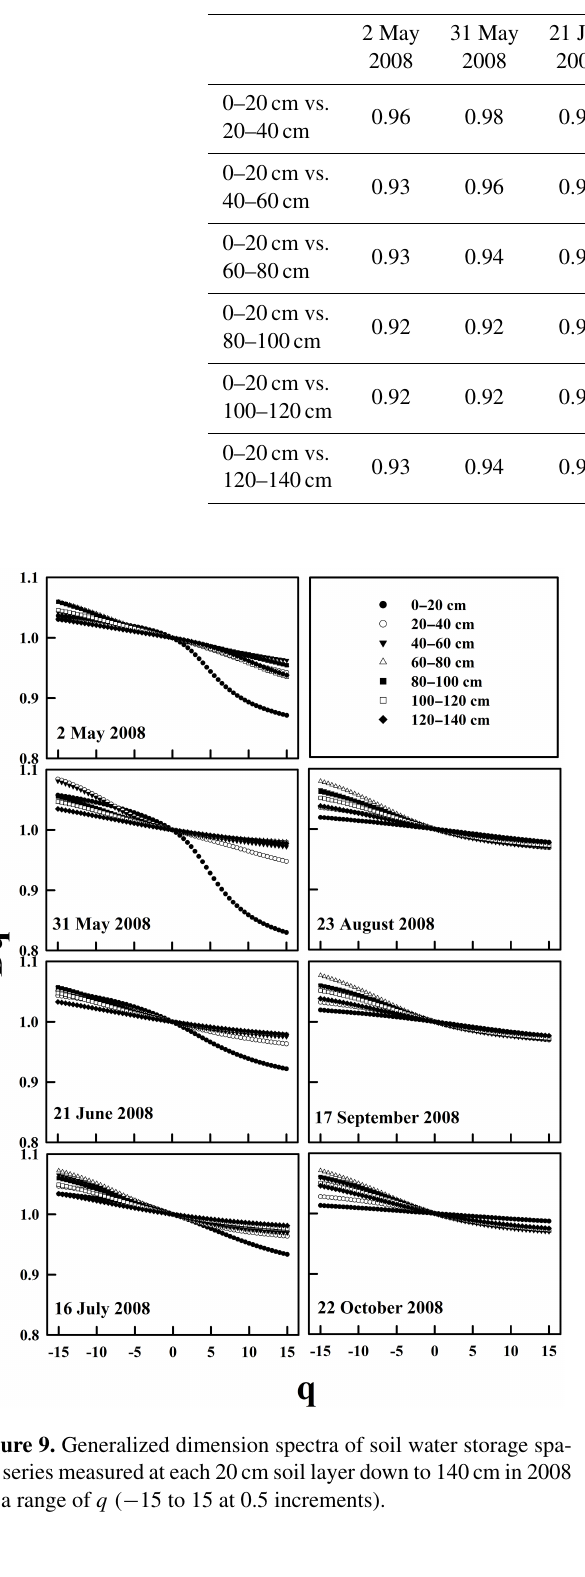
Table 2. Correlation coefficients between joint multifractal indices ( α and β ) ( n = 440) of the surface layer with those from subsurface layers at 20cm intervals in 2008.